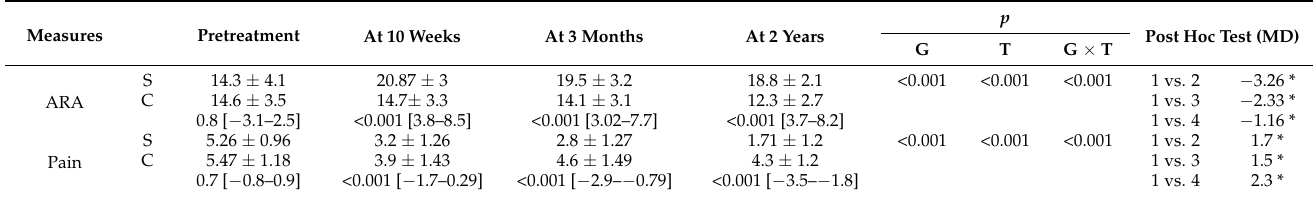
Table 2. The results for the repeated measures one-way analysis of variance (ANOVA) for the absolute rotation angle (ARA) cervical lordosis and pain intensity in both groups.